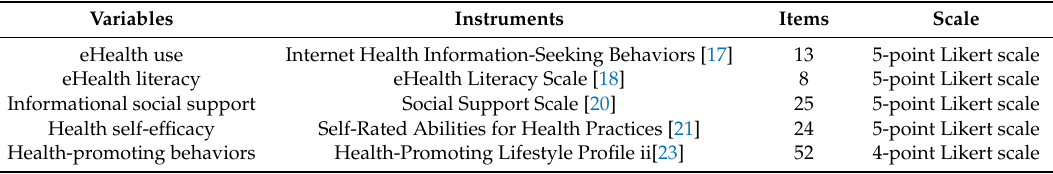
Table 1. Instruments for each